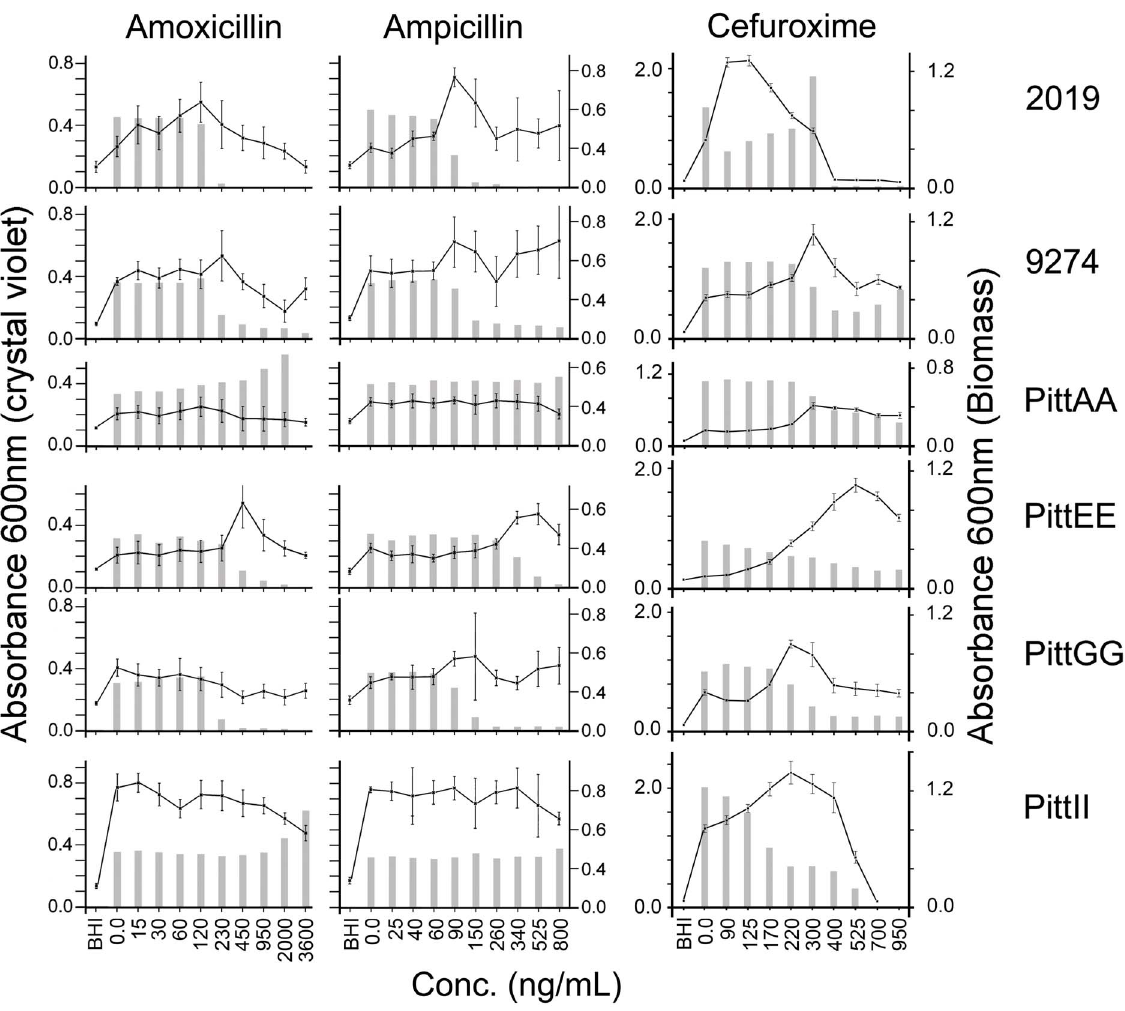
Figure 2. Biofilm formation is stimulated by beta-lactam antibiotics. Crystal violet assays of 1-day NTHi biofilms formed in the presence of amoxicillin or amoxicillin. Strains 2019, 9274 and PittEE reacted to inhibitory concentrations of antibiotic (grey vertical bars, Biomass OD 600 ) by producing more crystal violet stainable biofilm (line graph). This stimulatory effect was different for each bacterial strain. PittGG did not react with amoxicillin and produced an ambiguous reaction to ampicillin. PittAA and PittII were not affected by amoxicillin or ampicillin in the concentration ranges studied. Cefuroxime (0–950 ng/mL range) showed a biofilm-stimulatory effect on all the NTHi strains under study. Each strain exhibited biofilm stimulation in different concentrations of antibiotic. Strain 2019 was maximally stimulated at 100 ng/mL cefuroxime, PittGG and PittII at 220 ng/mL, 9274, PittAA at 300 ng/mL and PittEE at 525 ng/mL.